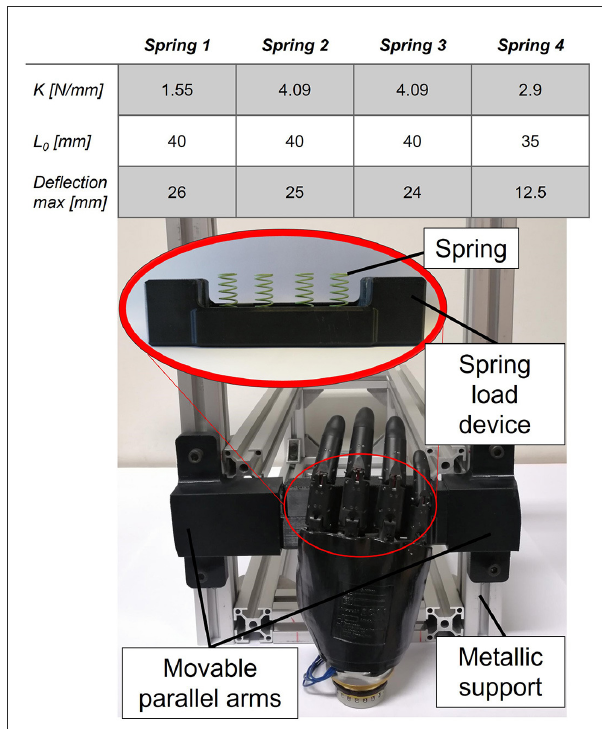
FIGURE3 Custom-made hand dynamometer mounted on test bench used for the classifier training. The device is composed of a base where at maximum four strings can be inserted, and a cover which can slide along the base when compressed by the prosthesis fingers. The test bench consists of a custom-made system composed by movable parallel arms and a two-cuff system acting as holder. The table represents the different spring force and levels to characterize the stiffness of the